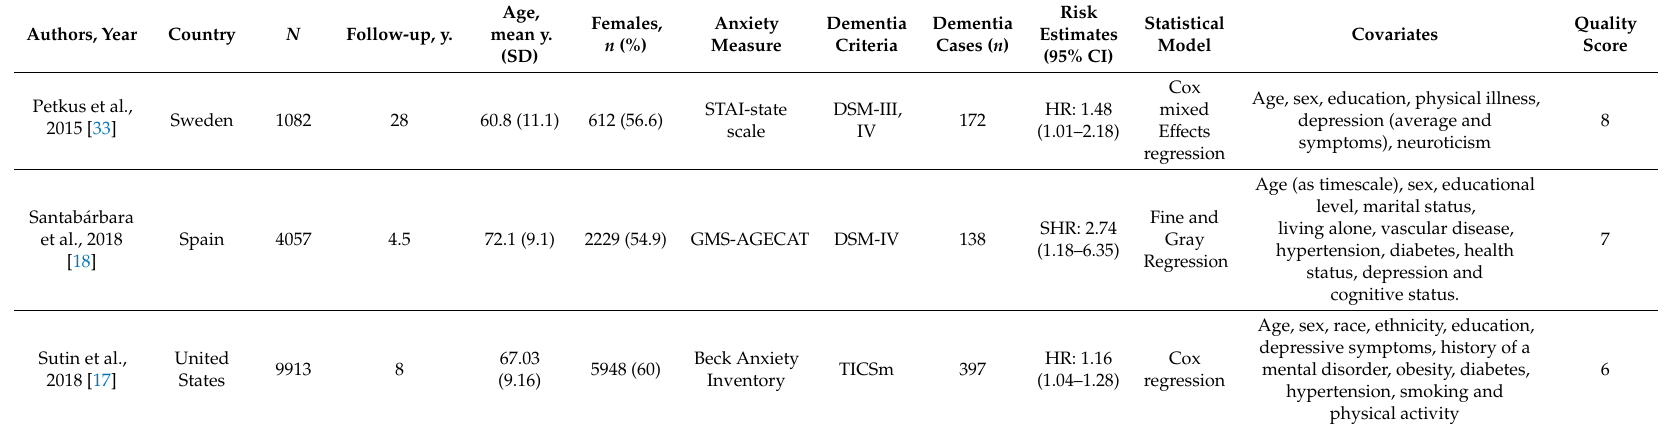
Abbreviations in the table: ApoE: Apolipoprotein E; DSM-III: Diagnostic and Statistical Manual, Third Edition; DSM- IV: Diagnostic and Statistical Manual, Fourth Edition; GAS: Geriatric Anxiety Scale; GHQ: General health questionnaire; GMS-AGECAT: Geriatric Mental State- Automated Geriatric Examination for Computer Assisted Taxonomy; HADS: Hospital Anxiety and Depression Scale; HR: Hazard Ratio; MCI: Mild Cognitive Impairment; NART: National adult reading test; NPI-Q: Neuropsychiatric Inventory Questionnaire; NR: not reported; OR: Odds Ratio; RR: Relative Risk; SD: Standard deviation; SHR: Subdistribution hazard ratio; STAI: State-Trait Anxiety Inventory; TICSm: modified Telephone Interview for Cognitive Status; y.: